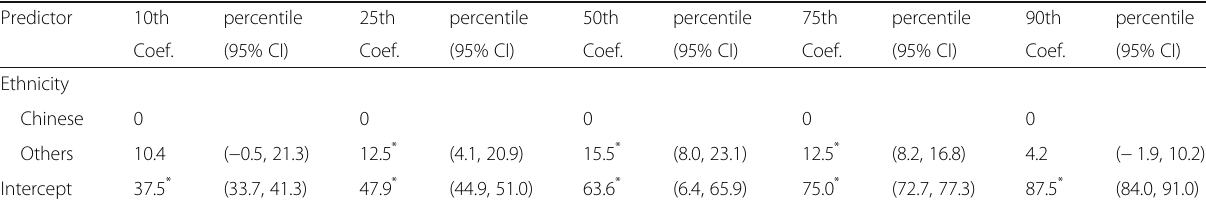
Table 6 Percentiles of QOL Experience & Meaning score, final model Predictor